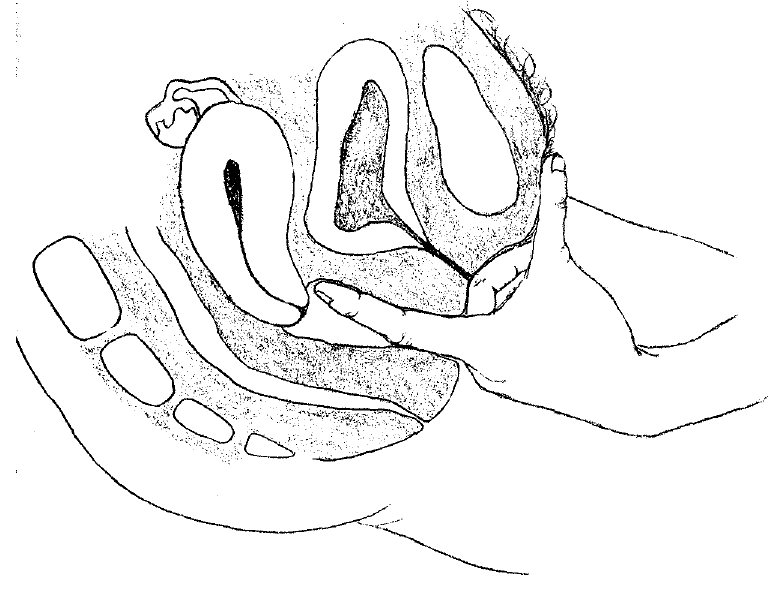
FIGURE 2. Sexual healing though the vagina by pressing on the tissues and helping the patient to identify and process the repressed feelings and old traumas held by the pelvic organs[47]. The vagina is penetrated with one or two fingers, and all the structures of the pelvis are systematically worked through. The patient is invited to open up to the